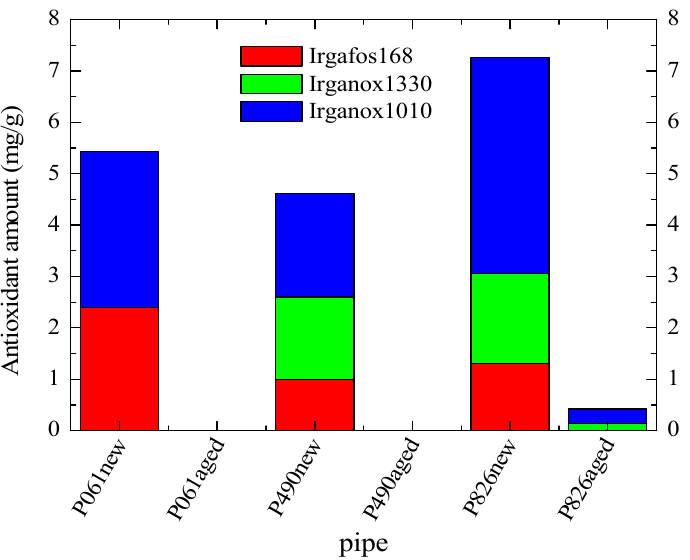
Figure 9. Antioxidant composition in the different new and aged pipes. The content of antioxidants in pipes P490aged and P061aged was found to be zero.